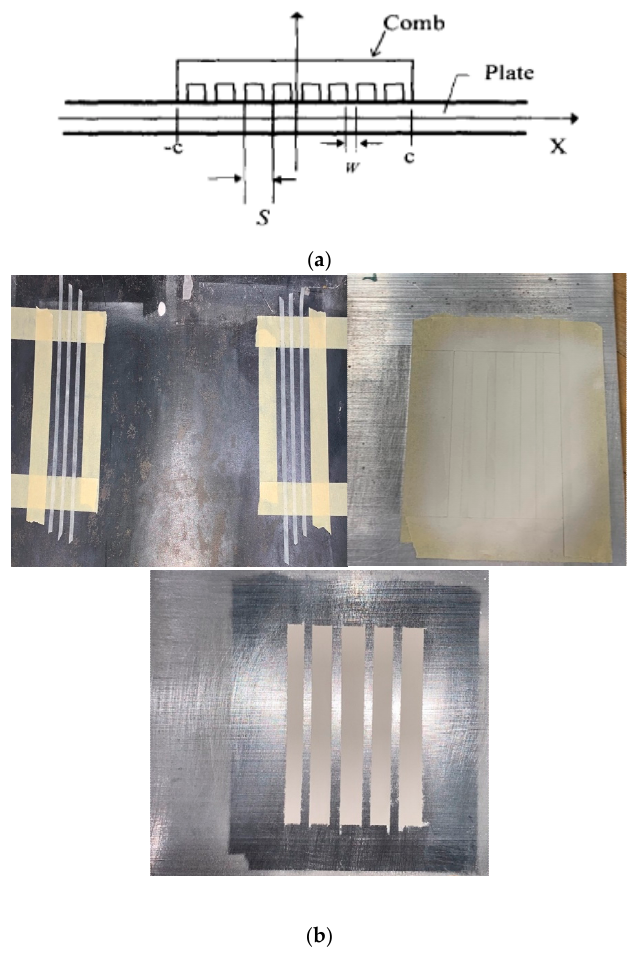
Figure 16. ( a ) S is the element width, W is the element gap, W + S is the wavelength of the traveling wave [7]; ( b ) Schematic of the experiment setup for generation of Lamb waves in a 3.2 mm thick 6061 aluminum plate [7].